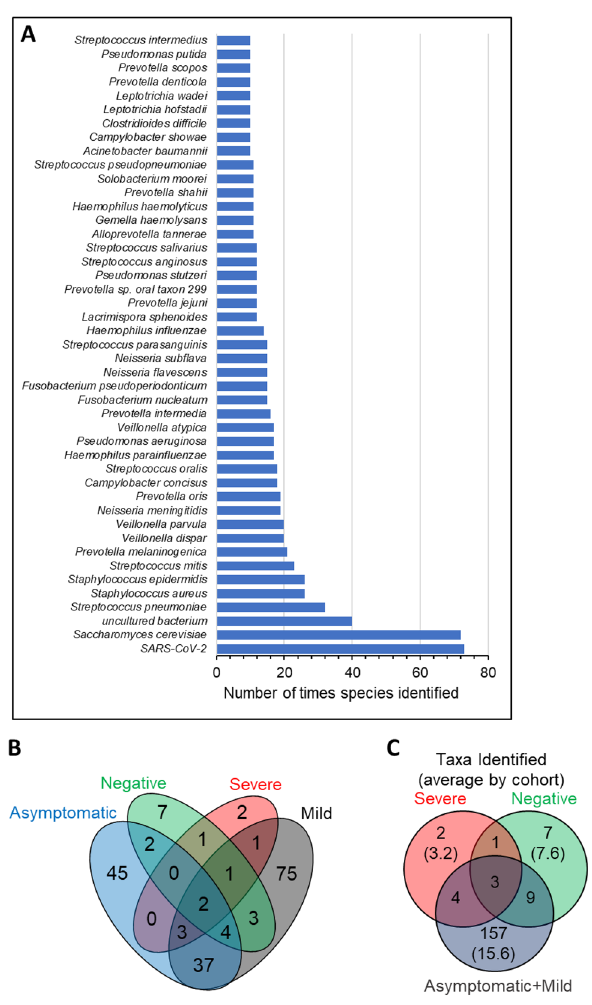
Figure 3. Taxa identified within nasopharyngeal swabs of SARS-CoV-2 cohorts. ( A ) Taxa identified within 10 or more samples. Data was analysed and chart produced in Microsoft Excel version 2212. ( B ) Venn diagram depicting the number of non-redundant taxa of each cohort that are also found within other cohorts. ( C ) Venn diagram depicting of the number of non-redundant taxa common to cohorts with Mild and Asymptomatic cohort data merged. Venn diagrams were generated using VennDiagram version